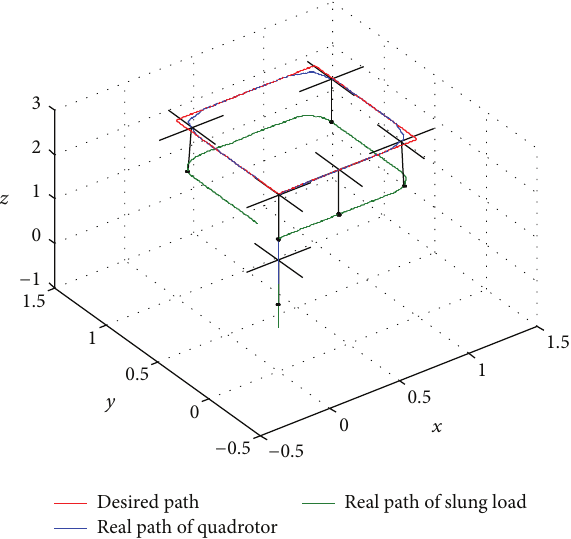
Figure 18: Square path of quadrotor with input shaping controller.